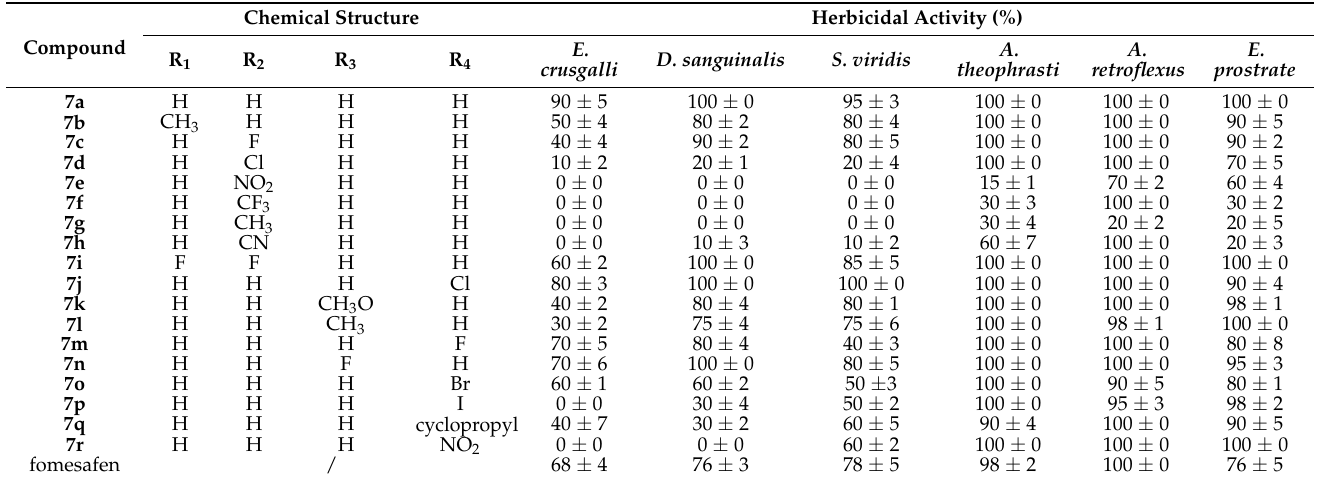
Table 1. The structures and herbicidal activities of α -trifluoroanisole derivatives at a 150 g a.i./hm 2 post-emergence treatment dose in a greenhouse assay